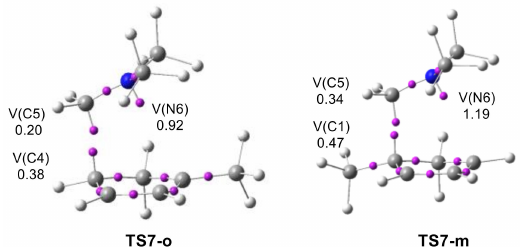
Figure 10. ELF basin attractor positions with the most significant valence basin populations of the regioisomeric TSs TS7-o and TS7-m involved in the I-DA reaction of CpMe 20 with iminium cation 6